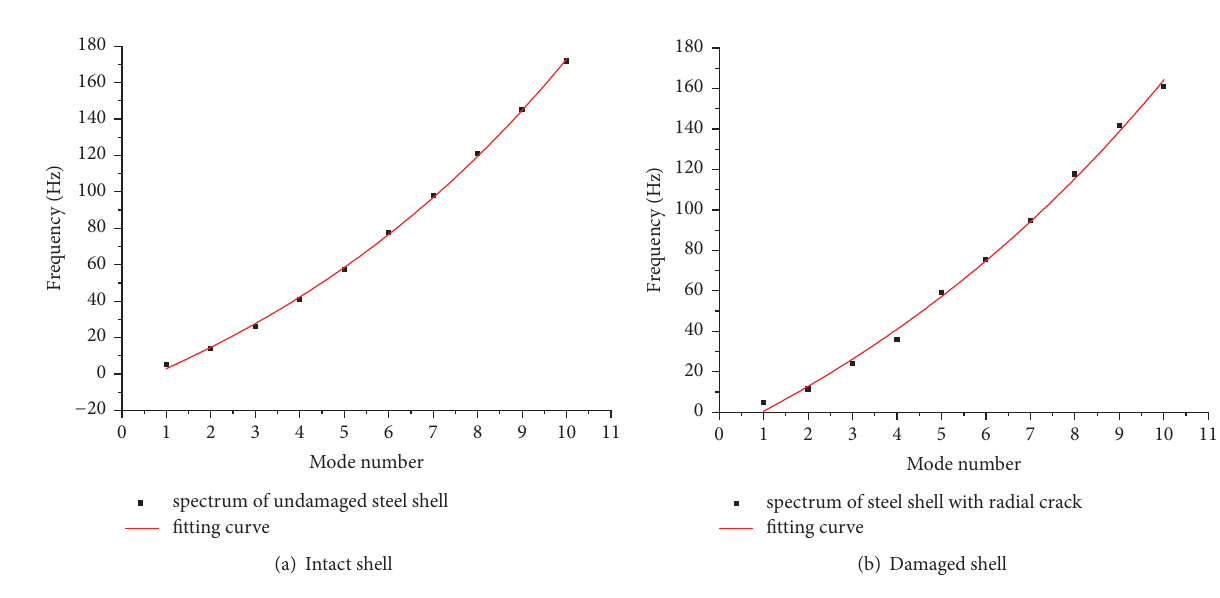
Figure 19: Comparison of spectrum fitting of intact and damaged shells.